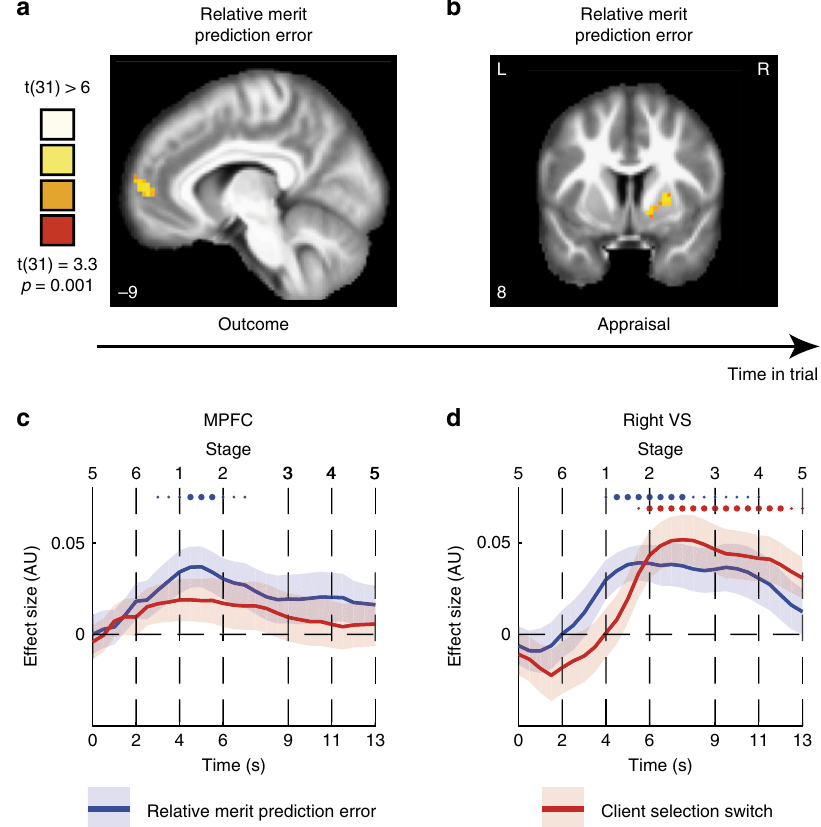
Fig. 5 Encoding of relative merit prediction errors. During the outcome stage, a whole brain analysis showed that activity in mPFC was positively modulated by the trial-by-trial relative merit prediction error, i.e. the differences between prognostic value comparison and previous reltive merit (Fig. 2d, eq. (1)) ( P < 0.001, FWE cluster size-corrected P < 0.05, see Figure S7 for uncorrected map). b During the Appraisal stage, activity in the VS followed the relative merit prediction error ( P < 0.001, FWE cluster size-corrected P < 0.05, see Figure S8 for uncorrected map). c Time course of the effects of relative merit prediction error (blue) and client selection switches (red) from the mPFC (MNI coordinates [x,y,z]: [ − 9,56,5]). Time courses are presented across all stages of a trial, from the showdown stage (5) of a preceding trial to the showdown stage (5) of the current trial. Thick lines indicate mean effect size, the shaddows indicate the SEM, small dots indicate P < 0.05 in these time points, and big dots indicate P < 0.005. These time courses demonstrate the temporal order of coding of relative merit and selection by client in VS. Thick lines: mean effect size. Shadows: SEM. d Time courses sampled from the right VS (coordinates: [18,8, − 10], de fi ned by Neurosynth), demonstrating the temporal order of coding of relative merit PE and client selection